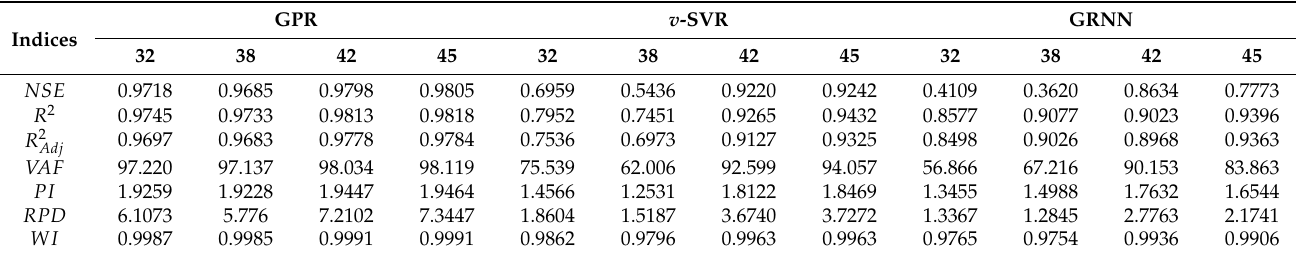
Table 4. Model accuracy of GPR, v -SVR, and GRNN methods in Case 1.